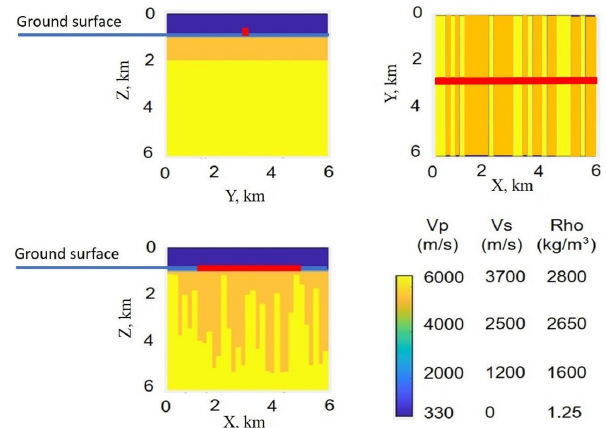
Figure 3. The synthetic model used for investigation of wave prop- agation. Position of the seismic profile marked by the red line. Low velocity corresponding to the air is indicated at the top in blue.